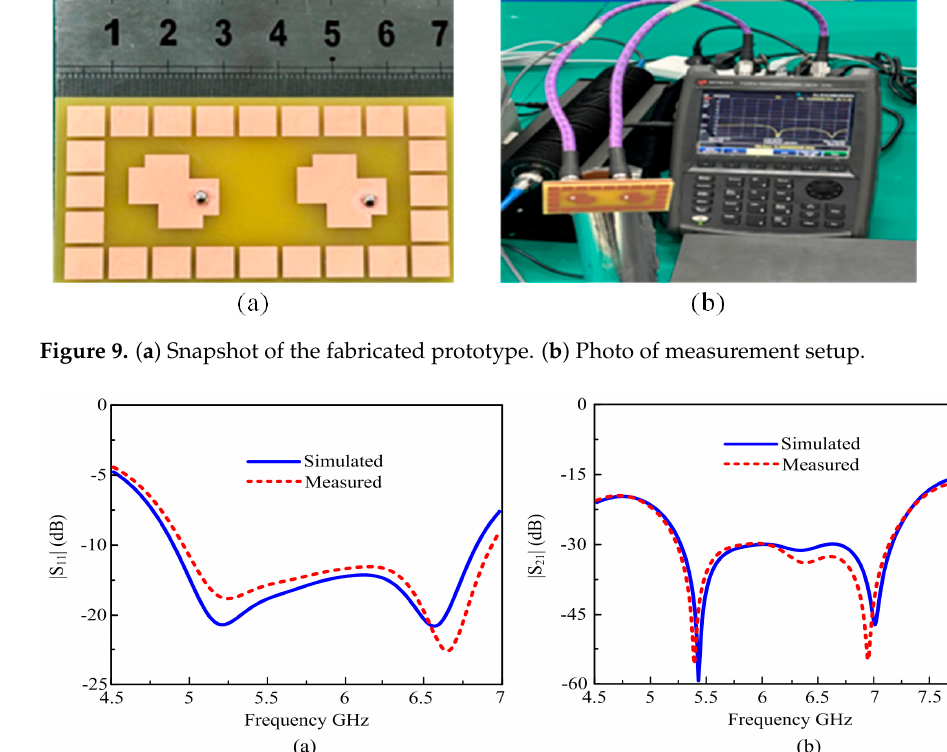
Figure 9. ( a ) Snapshot of the fabricated prototype. ( b ) Photo of measurement setup.